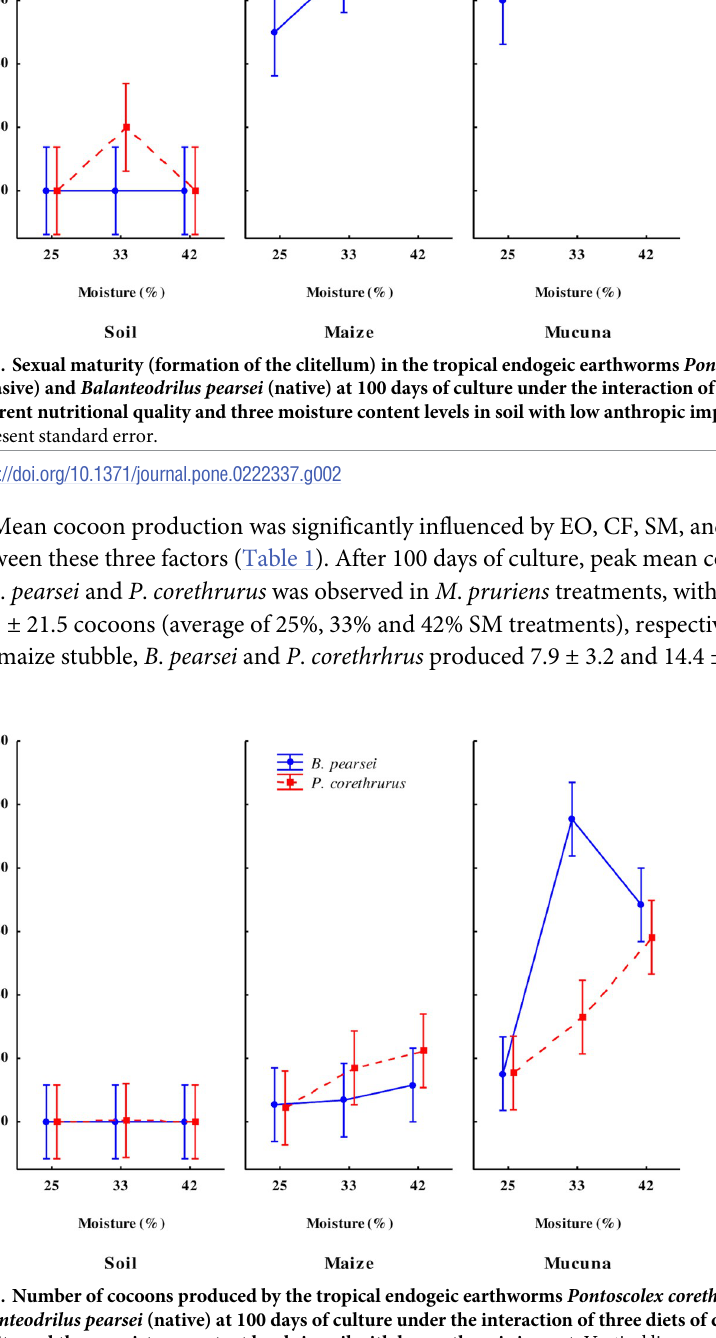
PLOS ONE | https://doi.org/10.1371/journal.pone.0222337 September 20,